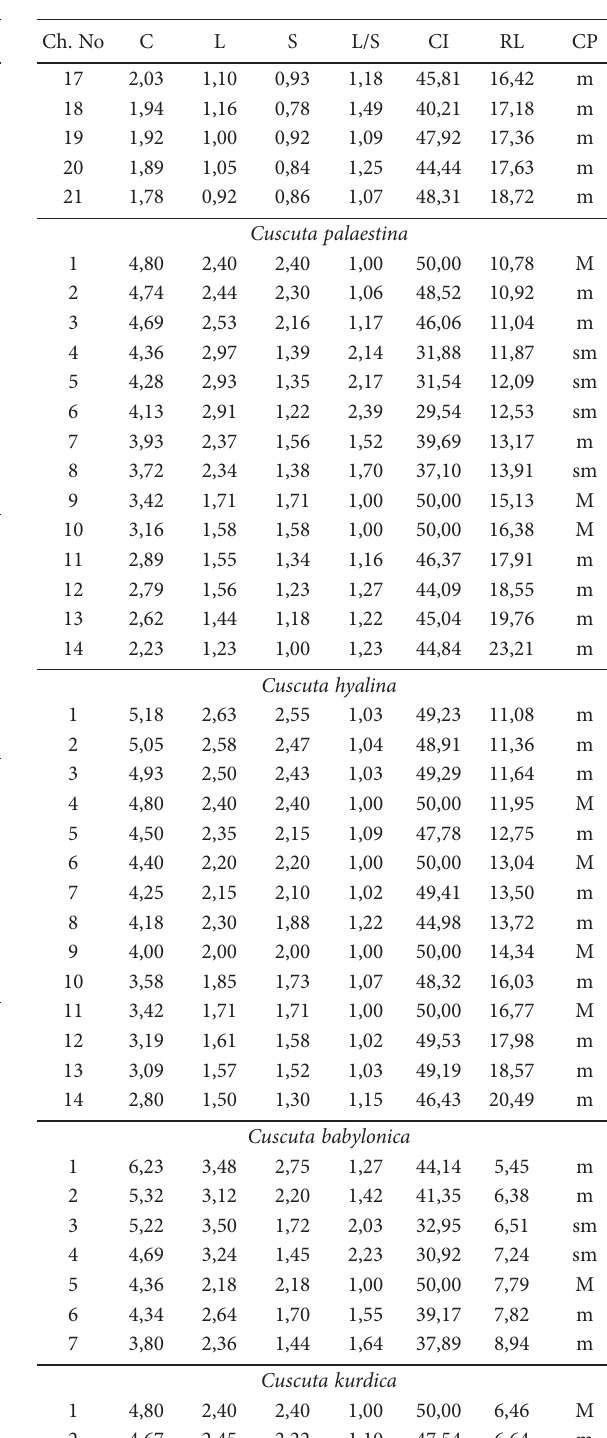
Table 2. Chromosomes measurements of Cuscuta taxa (Ch. No: Chromosome No, C: Total length of the chromosome, L: Length of the long arm, S: Length of the short arm, CP: Centromeric